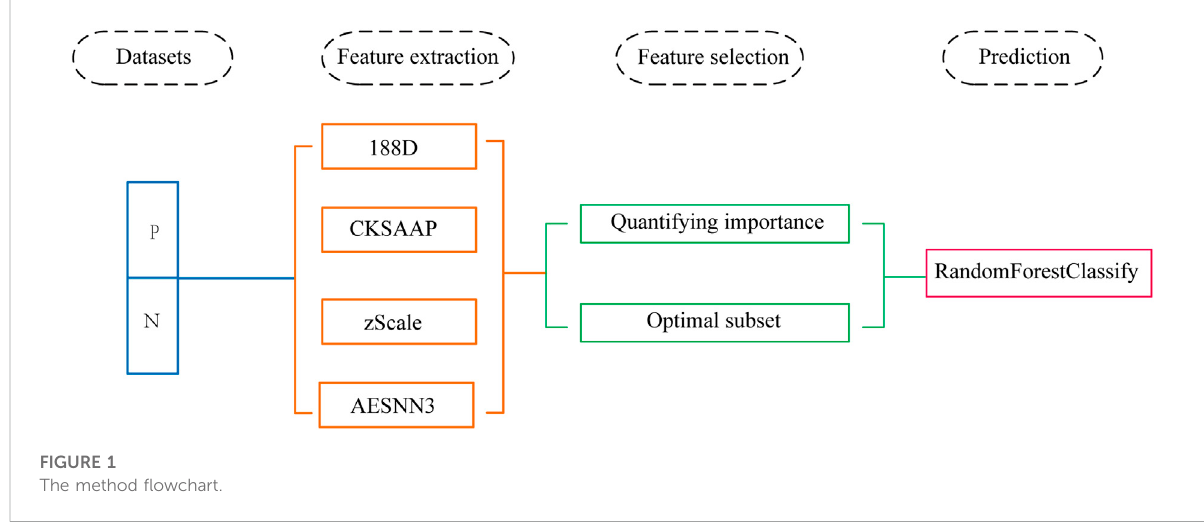
FIGURE 1 The method fl owchart.